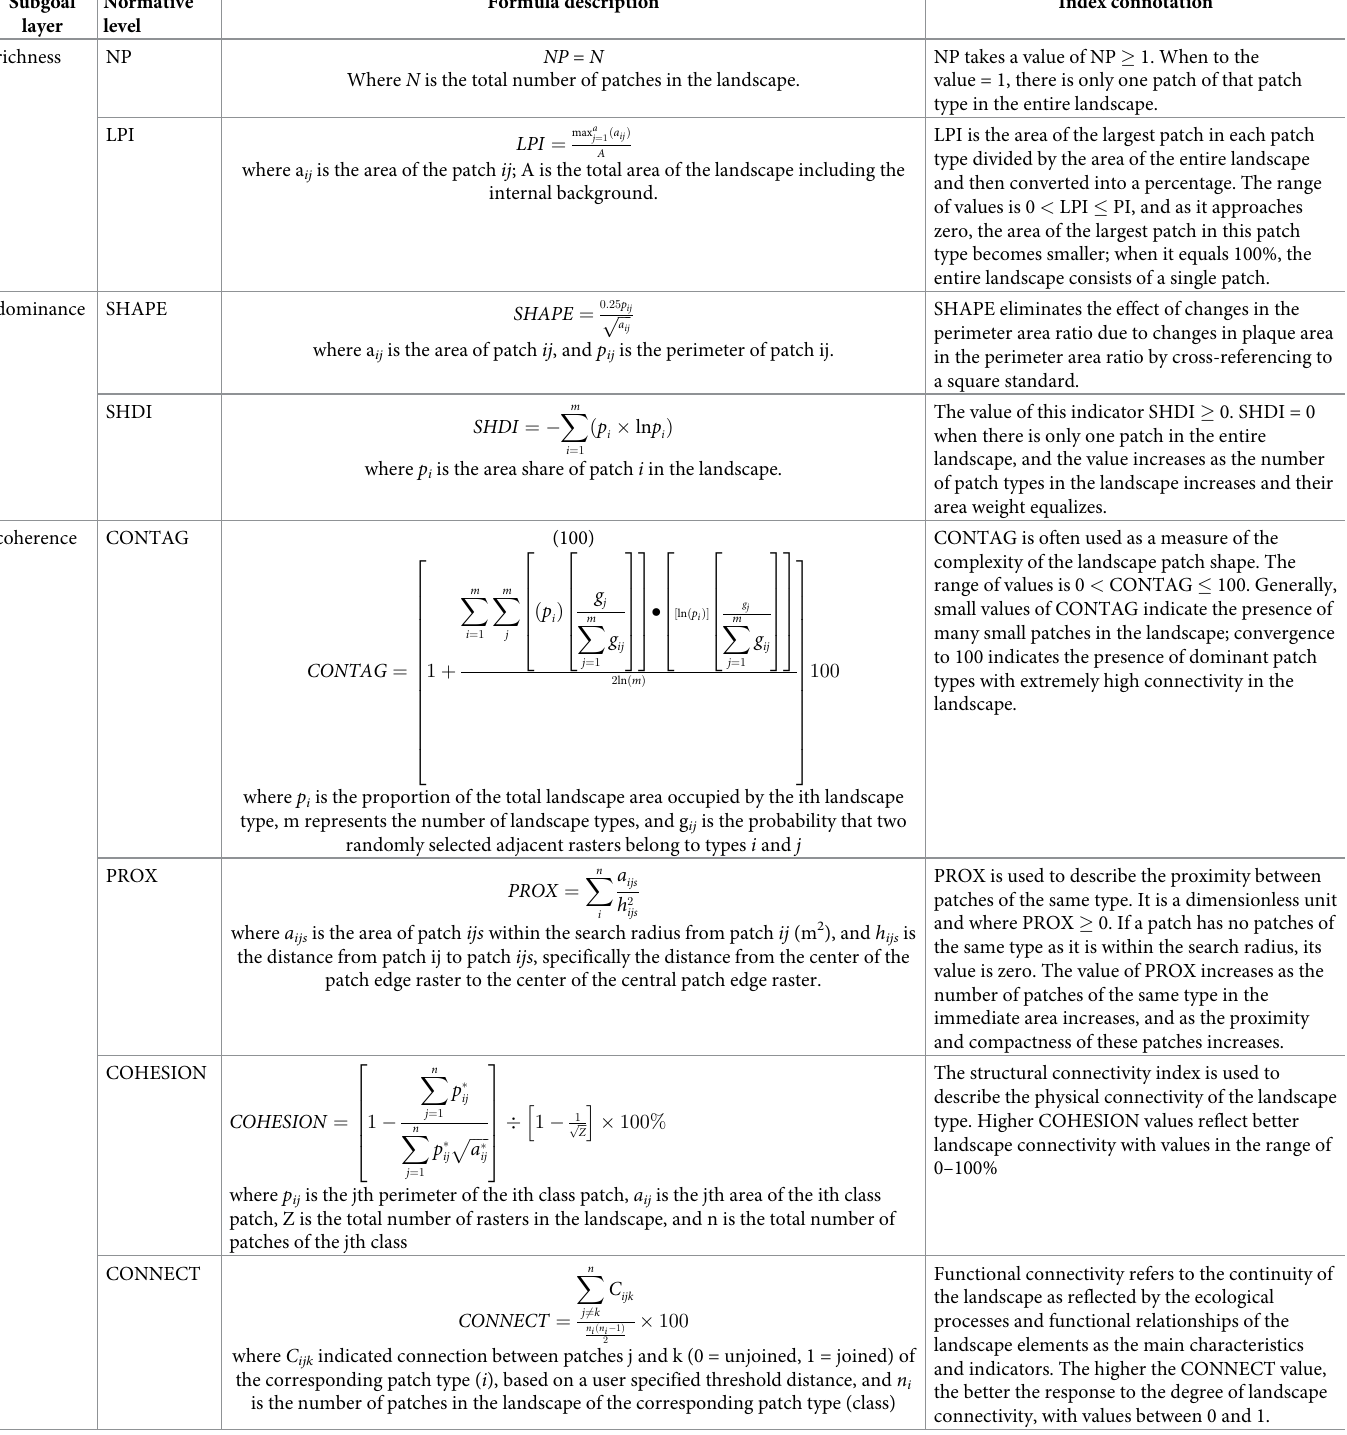
Table 3. Description of landscape